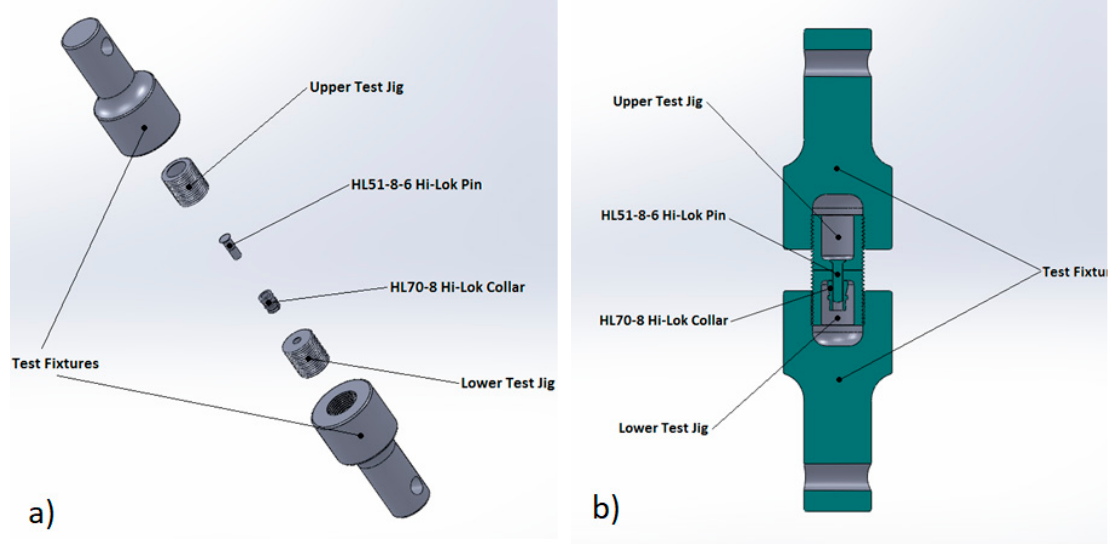
Figure 3. Static tension test assembly ( a ) exploded view and ( b ) cross section of the assembly.